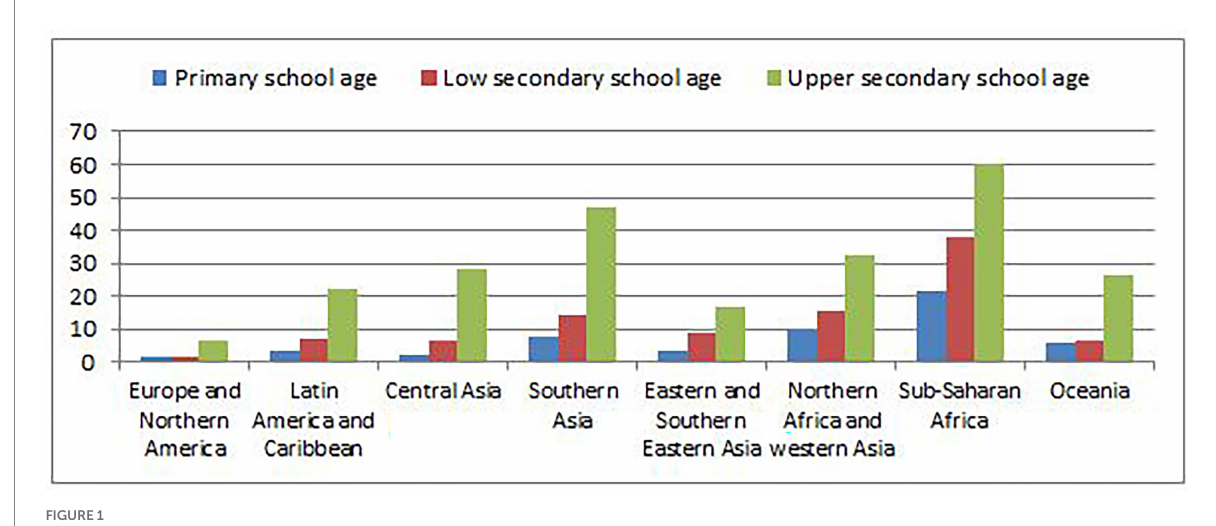
FIGURE 1 The percentage of out-of-school girl adolescents by